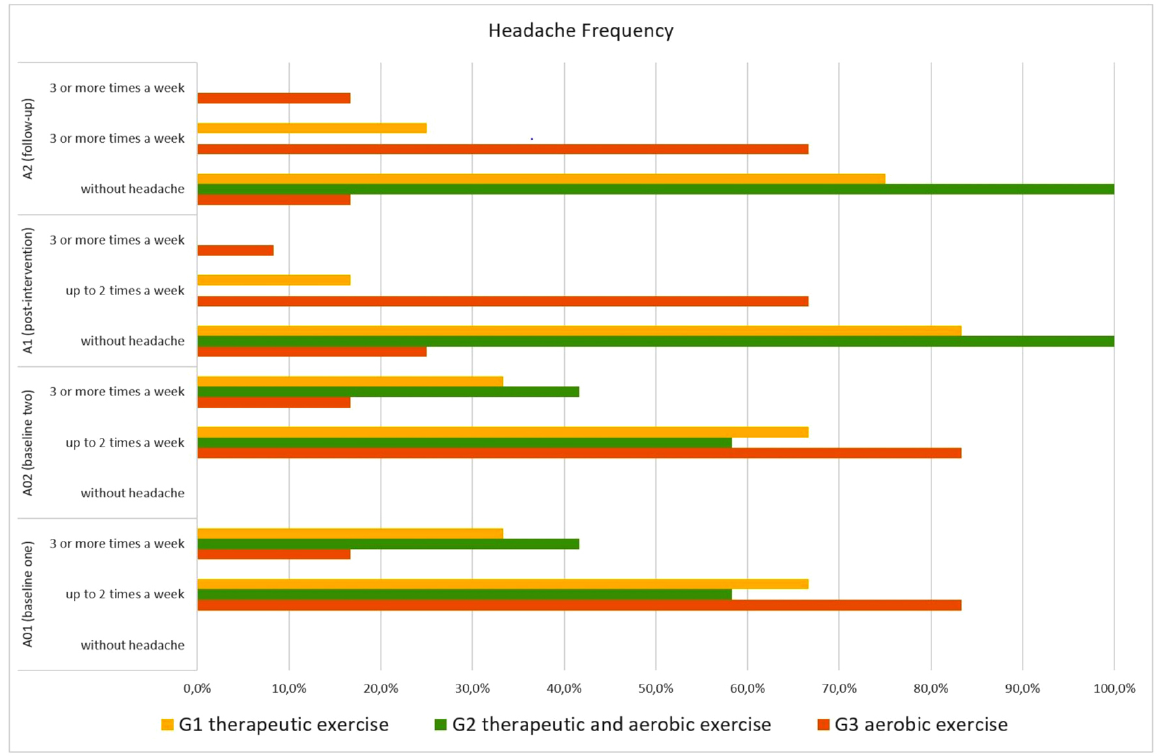
Figure 1- Changes in headache episodes per week assessed at different time points according to